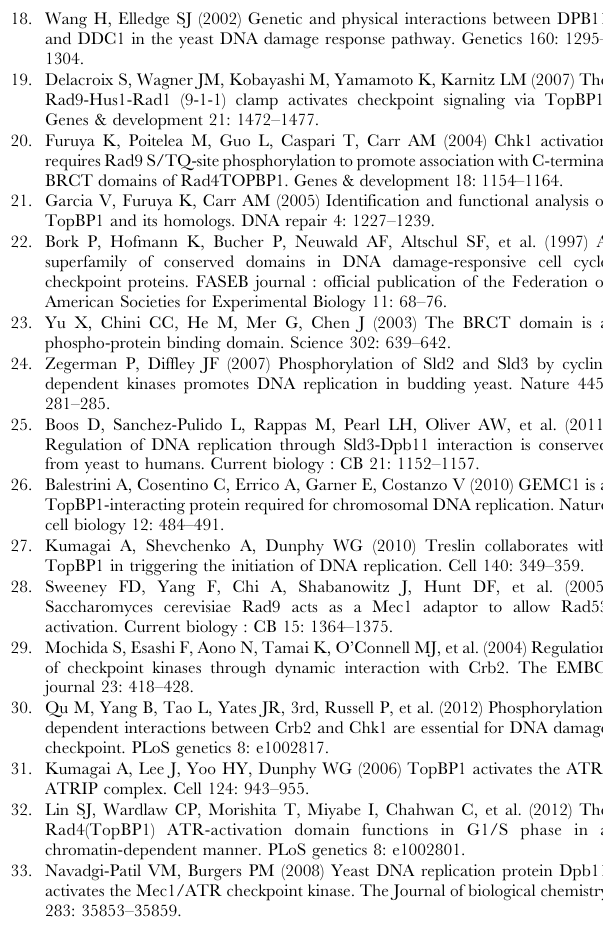
Figure S2 Expression analysis of AAD wild type and mutant TopBP1. ( A ) Sequencing results from RT-PCR products derived from + / + and ki/ + MEFs demonstrate the introduced knock-in mutation (T3439C, W1147R), and a silent mutation (T3477C, L1159L) from the targeted allele. ( B ) Immunoblot analysis of expression of endogenous TopBP1 in TopBP1 + / + and TopBP1 ki/ + MEF cells. Two samples of indicated genotype are shown. ( C ) Immunoblot analysis of expression of Flag-tagged wild type and AAD mutant TopBP1 in Cos7 cells. Two samples of each transfection are shown. Figure S3 Establishment of AAD mutant cellular system. We took advantage of the existence of the knock-in T3439C (W1147R) mutation and of a silent mutation (T3477C) that was discovered in the sequence of the targeted allele to establish an allele-specific knock-down strategy. ( A ) Schematic of the vector- base shRNA knock-down strategy. shTop1 and shTop2 oligos are designed to specifically target wild type TopBP1 allele, but avoid the introduced mutation (T3439C, W1147R) and silent mutation (T3477C, L1159L), respectively. ( B ) A schematic diagram of screening of shRNA oligos. shRNA were transfected together